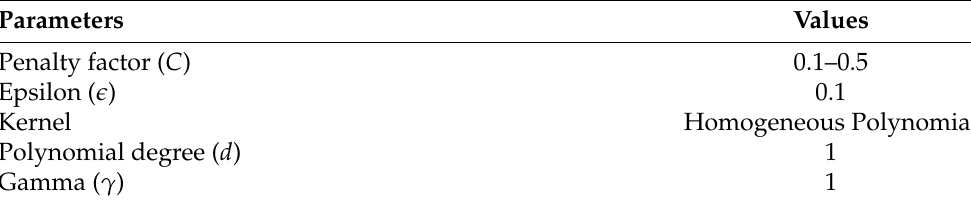
Table 3. Simulation parameters of the SVR